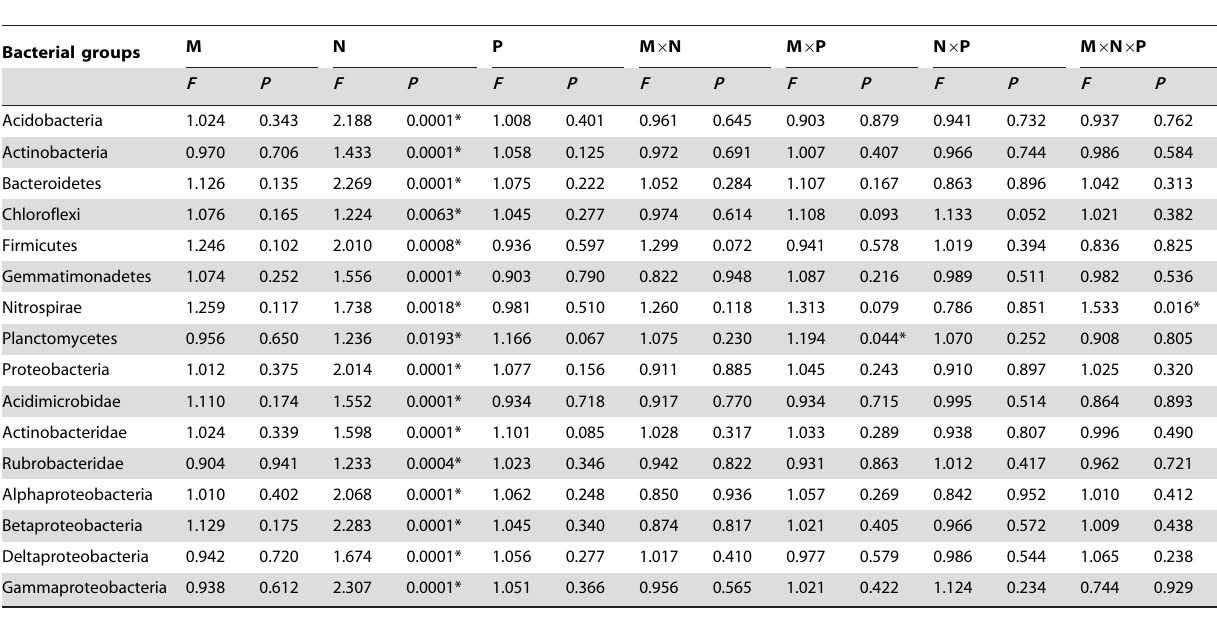
Table 1. The effects of mowing (M), nitrogen addition (N), phosphorus addition (P) and their combination on the composition of the 16 dominant bacterial phyla/classes revealed by